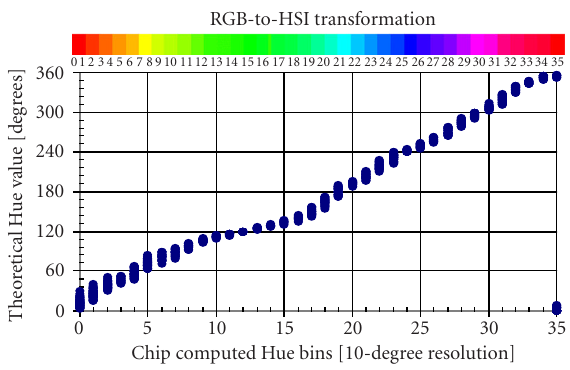
Figure 11: Hue (H) bin assignment for various RGB combinations. The color band shows the input.